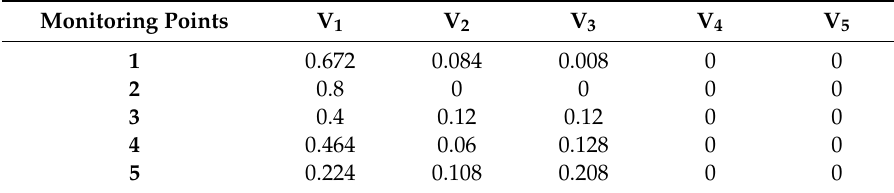
Table 4. The BPAs of the five monitoring points for the first